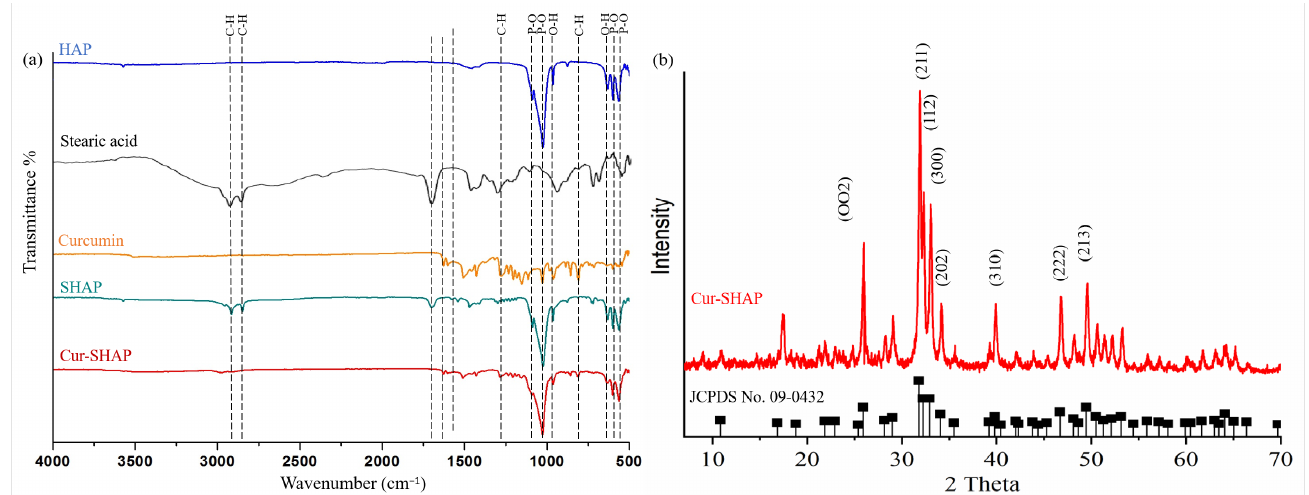
Figure 2. Identification of the functional groups and crystal structure of Cur-SHAP. ( a ) The absorption bands at 567, 604, and 3386 cm − 1 were attributed to HAP. The absorption bands at 2924 and 2866 cm − 1 were attributed to stearic acid. The absorption bands at 1510 and 1276 cm − 1 were attributed to curcumin. Cur-SHAP displayed all the characteristic absorption bands contributed by HAP, stearic acid, and curcumin. ( b ) X-ray diffraction patterns of HAP, SHAP, and Cur-SHAP. All characteristic peaks matched those of the standard pattern of HAP in no. 09-0432 of the JCPDS card.